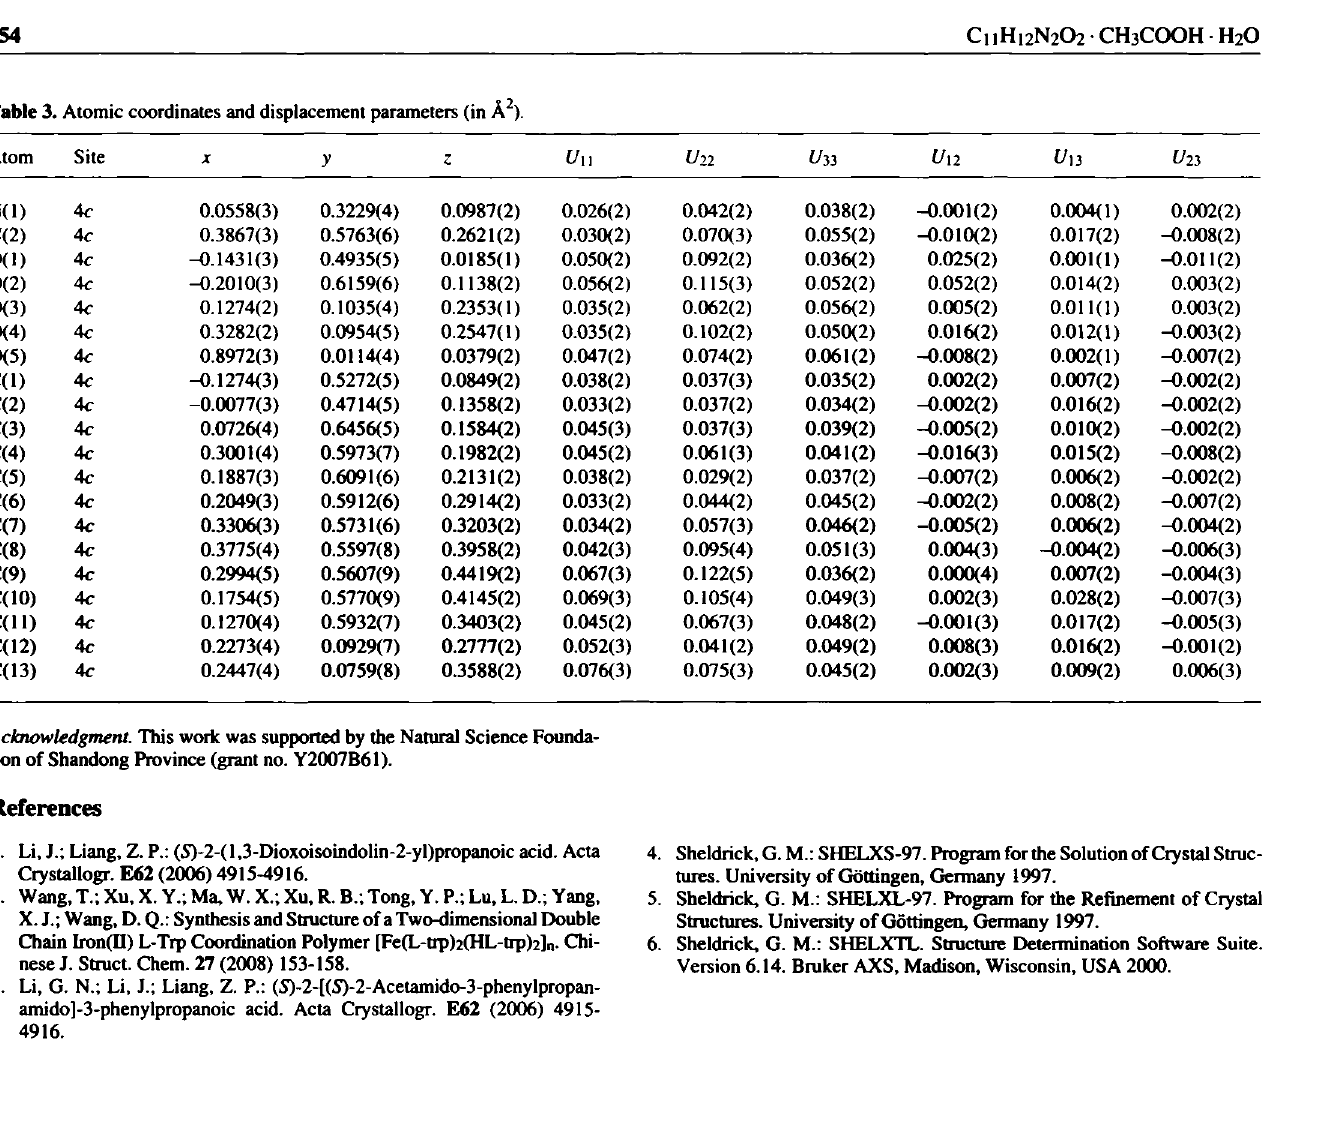
Table 3. Atomic coordinates and displacement parameters (in Â 2